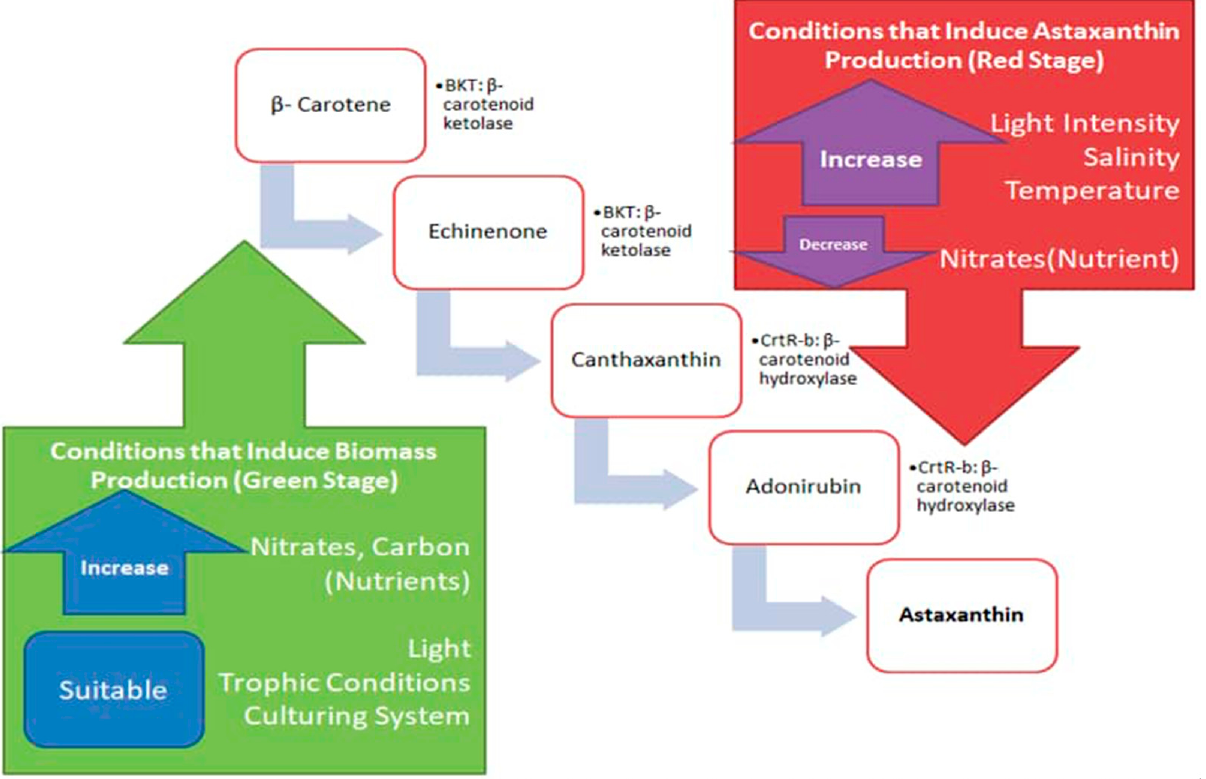
Figure 2. Astaxanthin formation pathway from β -carotene and conditions that induce the biosynthesis of astaxanthin in H. pluvialis.